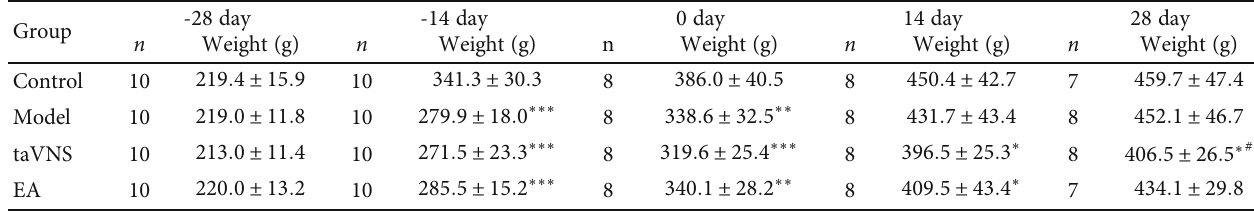
Table 1: Comparison of weight in each group at di ff erent time points ( (cid:1) x ± s ). Group